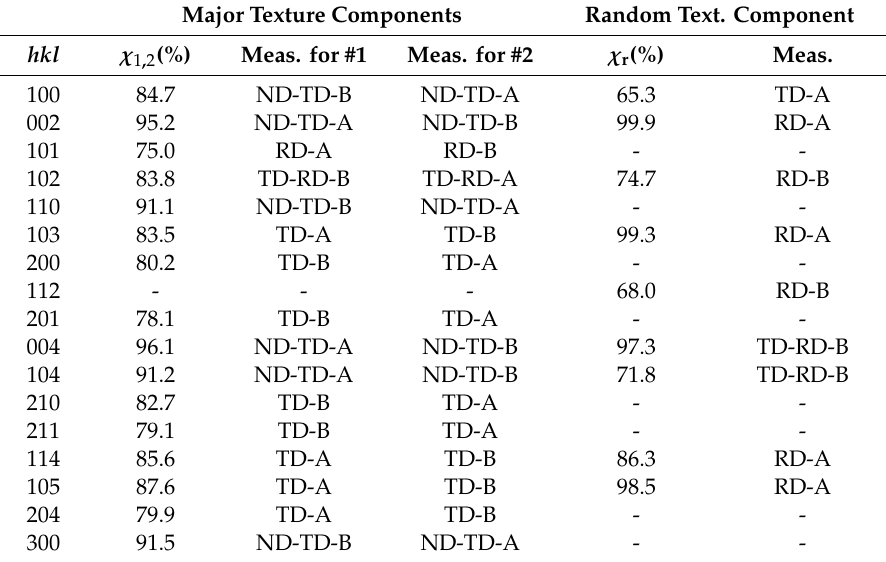
Table 4. values from measurements on differently cut surfaces gathered for TSDPs in the case of 23% tensile-deformed specimen. The corresponding surfaces where the peaks used for TSDPs were measured are specified.